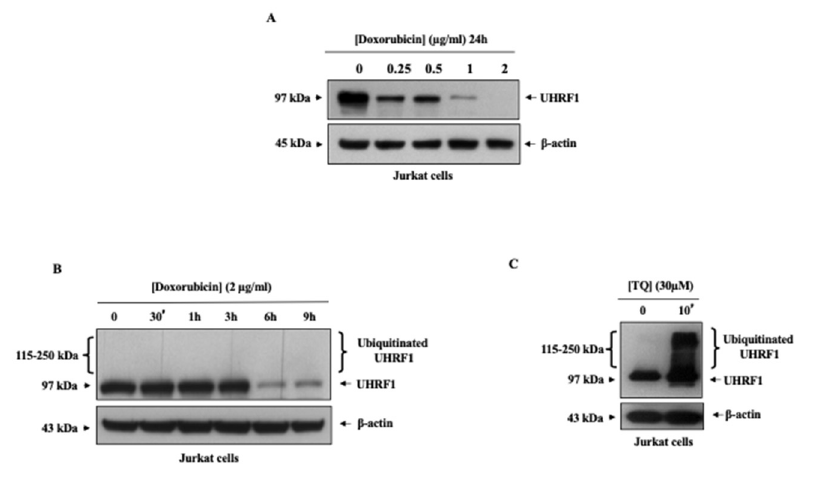
Figure 3. Dose- and time-dependent effects of doxorubicin and TQ on the protein expression of UHRF1 and ubiquitinated UHRF1 in Jurkat cells. ( A ) Jurkat cells were exposed to increasing concentrations of doxorubicin for 24 h. ( B ) Cells were exposed to 2 μ g/mL doxorubicin for different times. ( C ) Cells were exposed to 30 μ M TQ for 10 min. Expression of UHRF1 was analyzed via Western blotting, as described in the Materials and Methods.